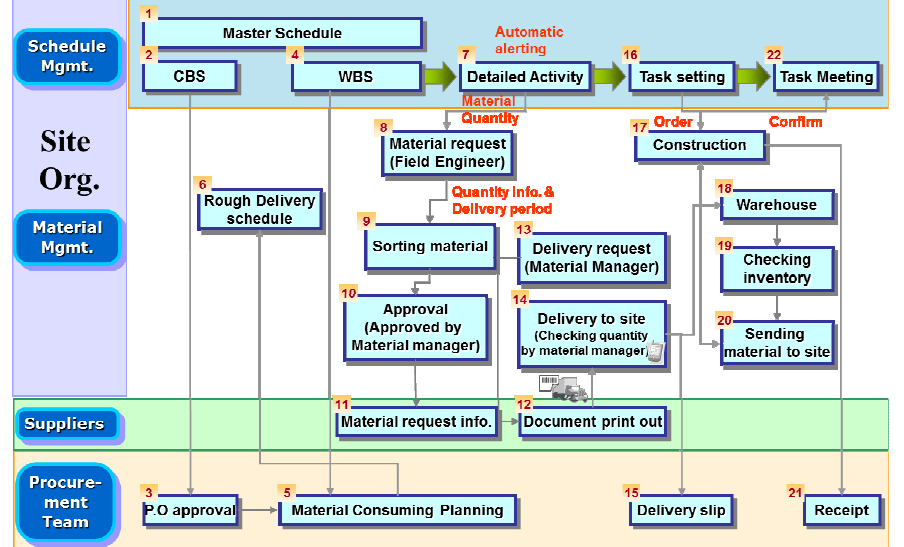
Fig. 10. System workflow